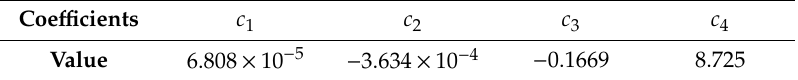
Table 3. Identification of coefficients of the model.